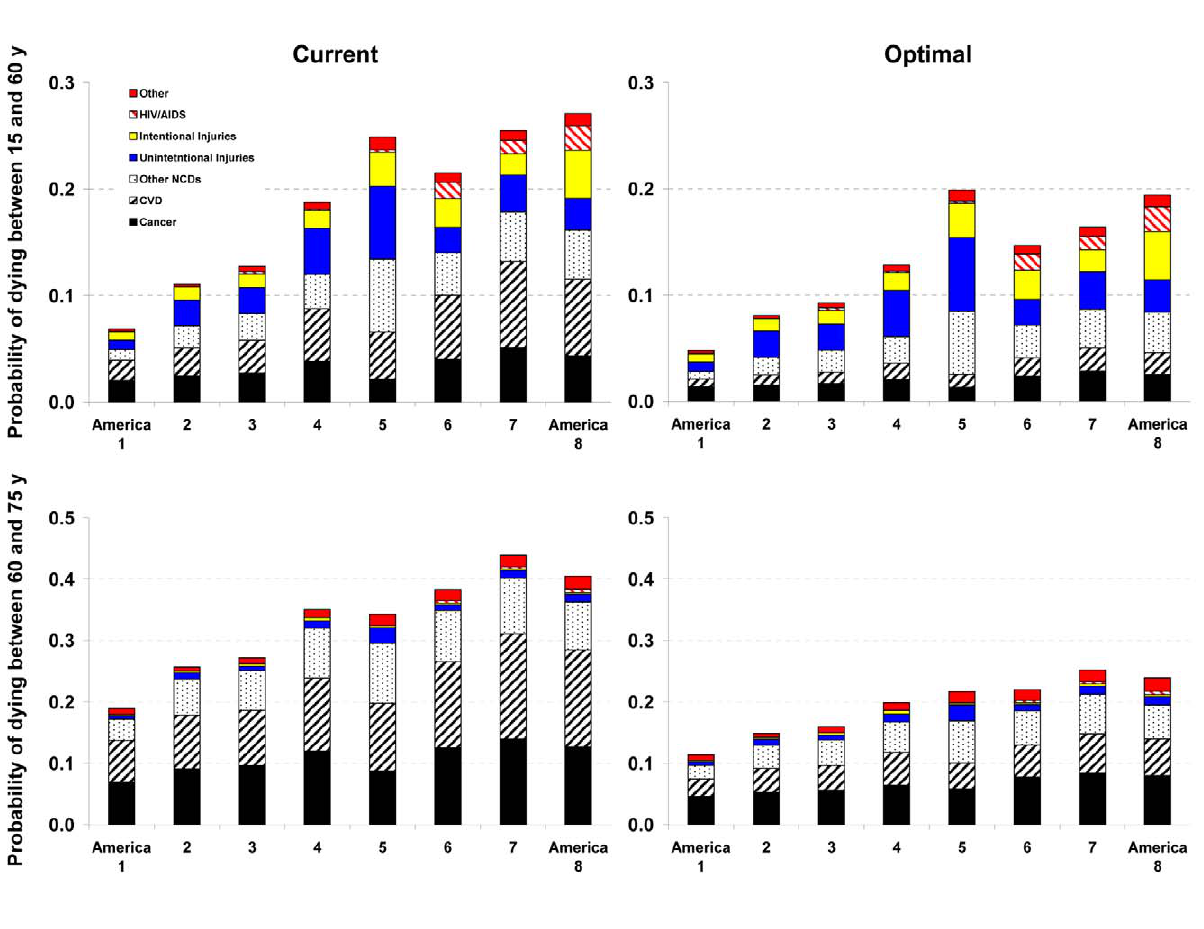
Figure 2. Probability of death from different medical causes between 15 and 60 years of age ( 45 Q 15 ) and between 60 and 75 years of age ( 15 Q 60 ) in the current and optimal distributions of risk factors in the Eight Americas in men. See definitions of the Eight Americas in Table 1.